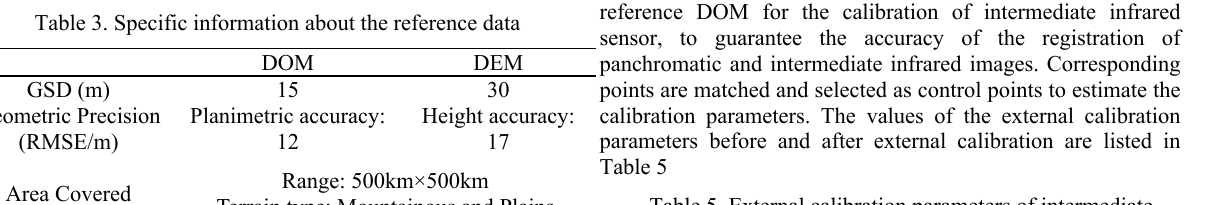
Table 5. External calibration parameters of intermediate